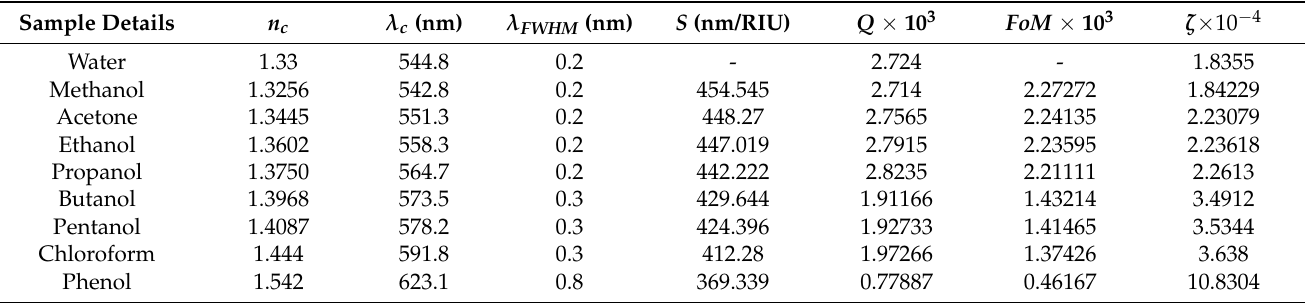
Table 5. Bio-alcohol sensor performance with d c = 230 nm corresponding to θ = 70 ◦ .